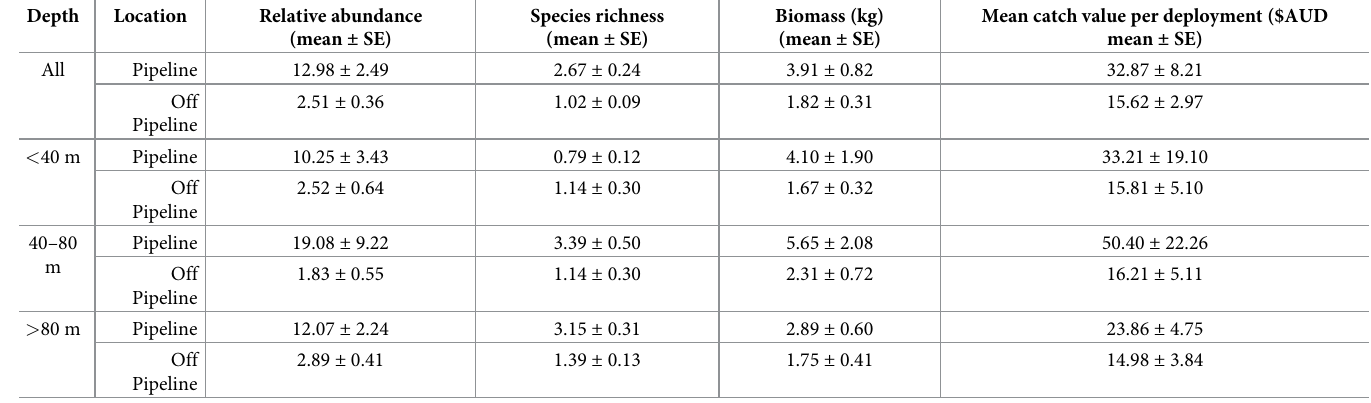
Table 6. The mean total biomass (kg) of major commercial species and the mean ‘catch value’ per deployment ($) of all major commercial species on and off-pipe- line for each depth category and the entire study area.